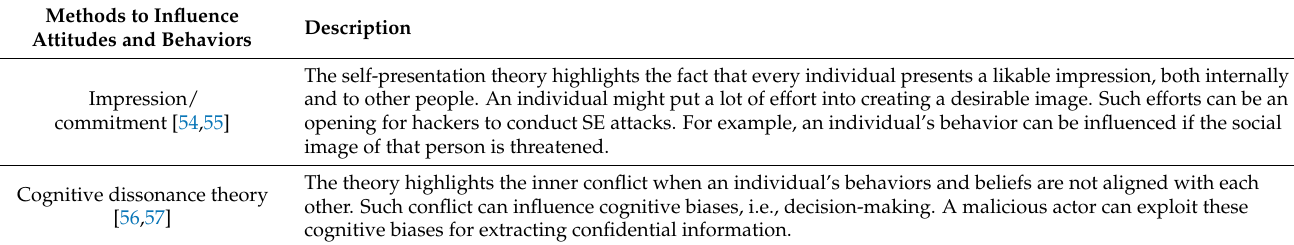
Table 5. Methods to influence the attitudes and behaviors of victims to conduct social engineering